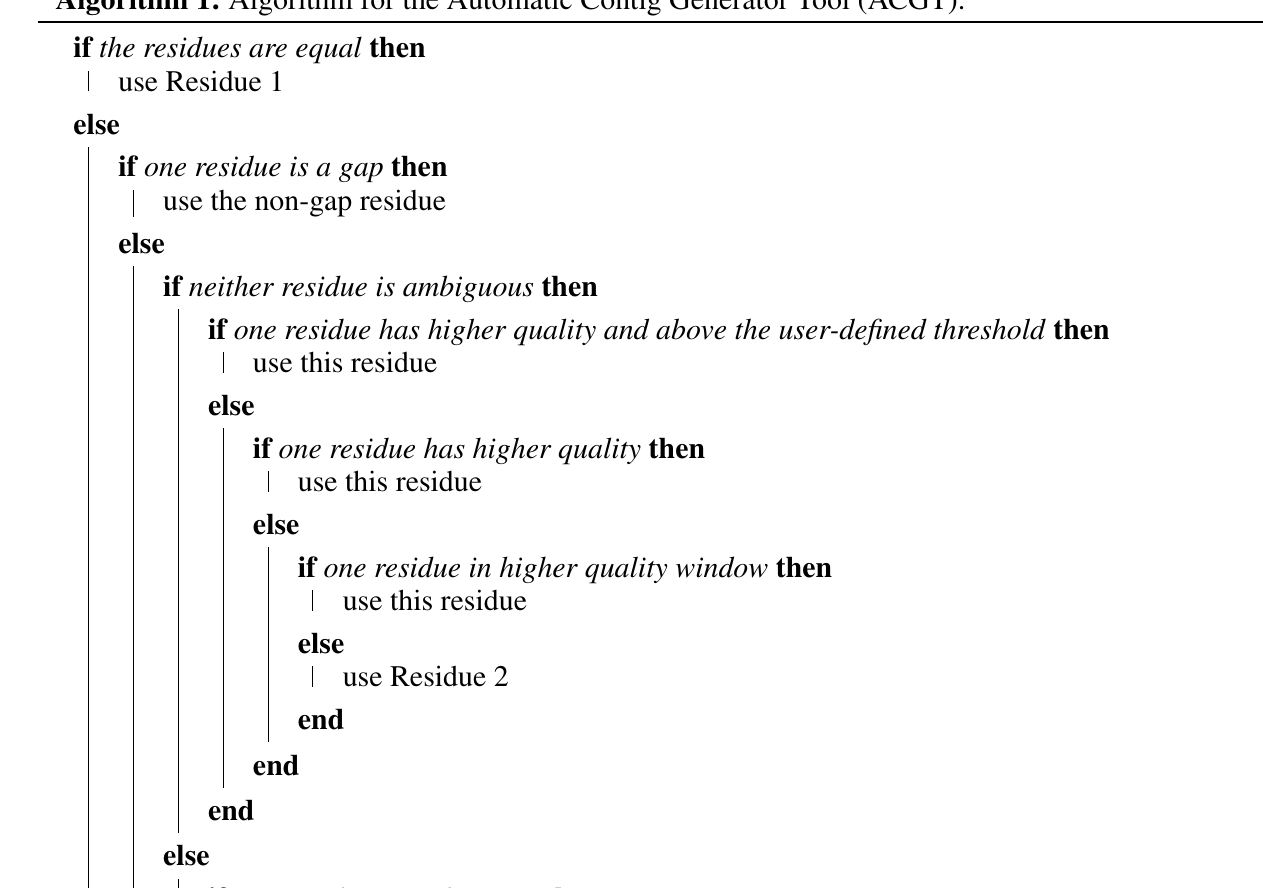
Algorithm 1: Algorithm for the Automatic Contig Generator Tool